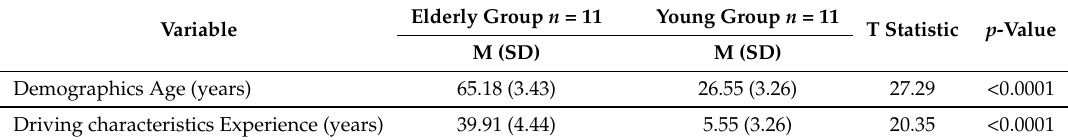
Table 1. Characteristics of the Young and Elderly